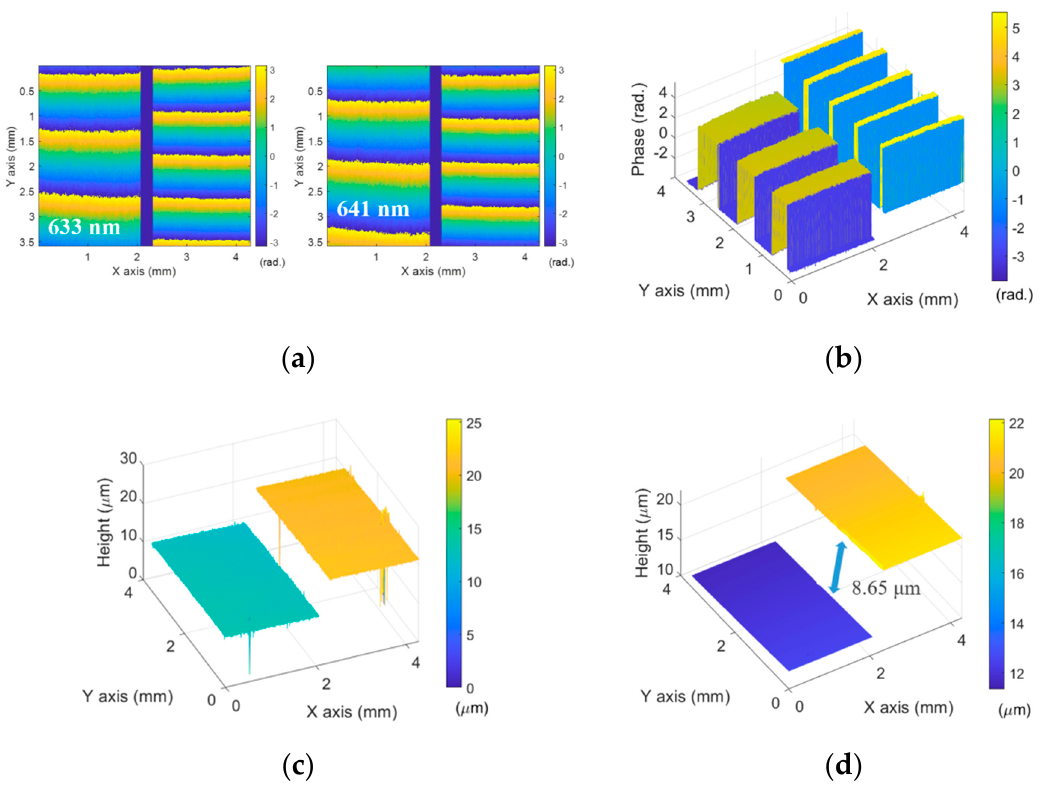
Figure 6. ( a ) Wrapped phase maps at 633 nm ( 𝜆 1 ) and 641 nm( 𝜆 2 ); ( b ) equivalent phase map ( Φ 12 ); ( c ) height map by Φ 12 ; ( d ) calibrated height map of the step height specimen.